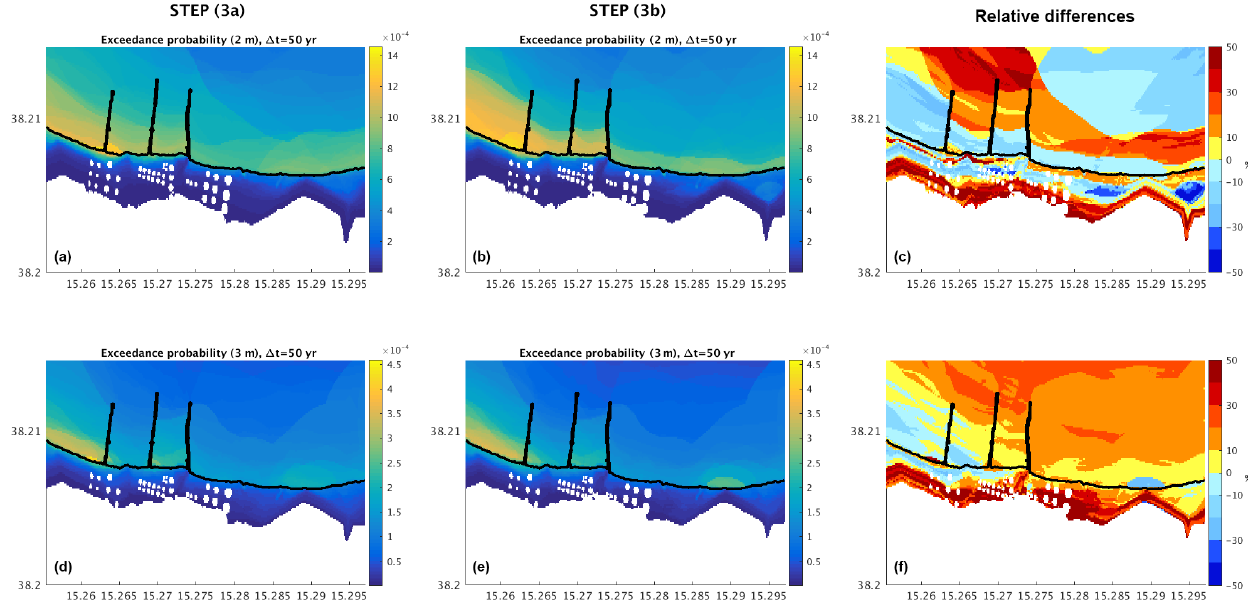
Figure 4. Probability maps (inner grid; see text) for H max derived from the hazard curves in Fig. 3 at two different thresholds (2 and 3m) for steps (3a) and (3b) and relative differences, which are computed as follows: [ ( 3a ) − ( 3b ) ] /( 3b ) .